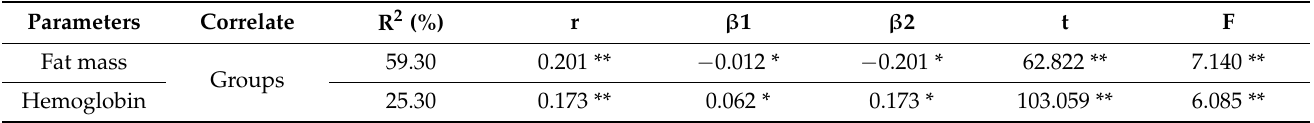
Table 4. Regression table of quality-of-life parameters according to research